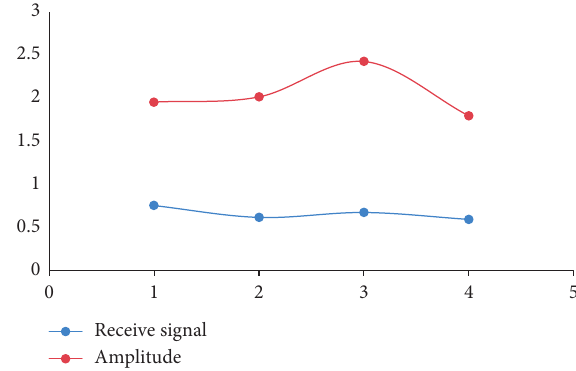
Figure 5: Influence of materials on